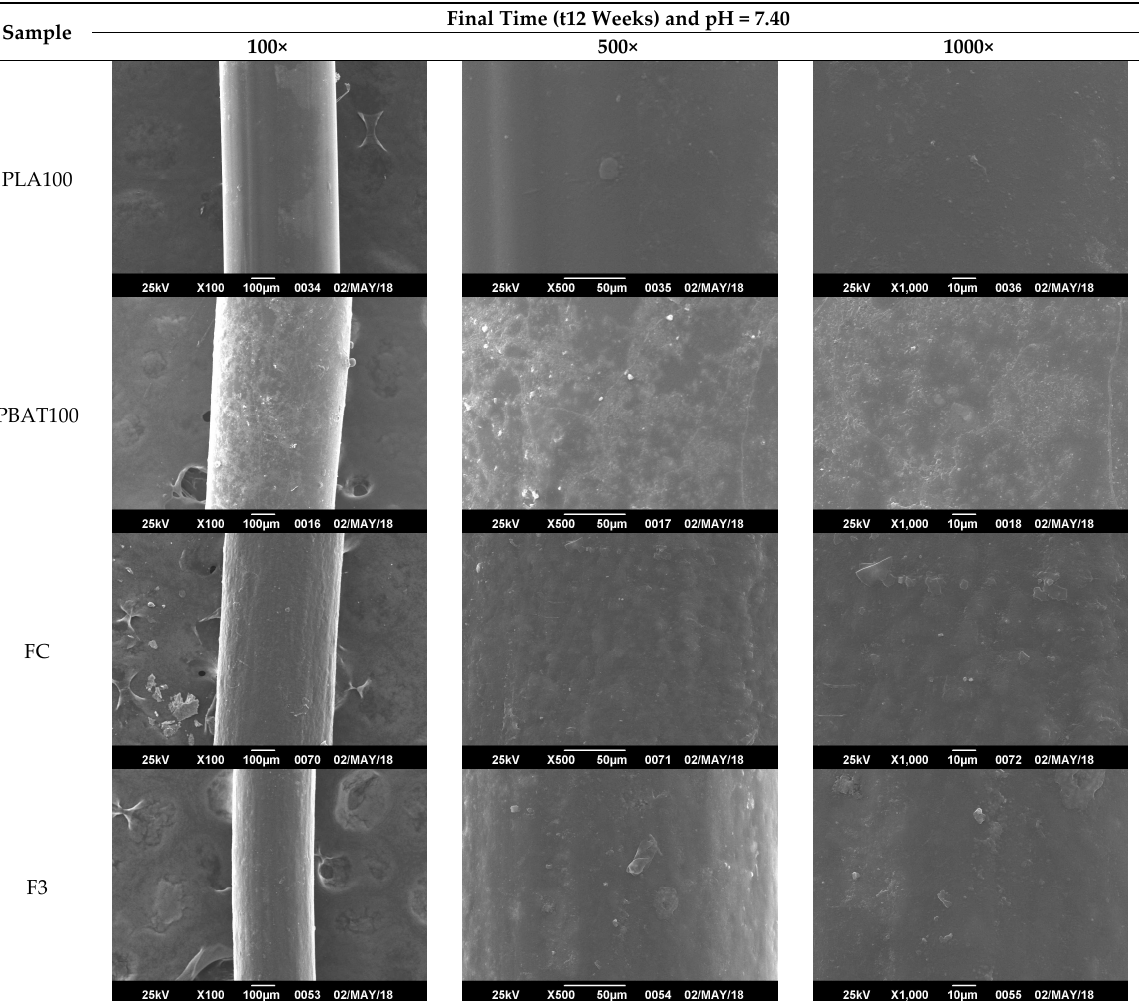
Figure 13. SEM micrographs of fibers’ surface morphology degraded for 12 weeks at pH = 7.40 and T = 25 °C.